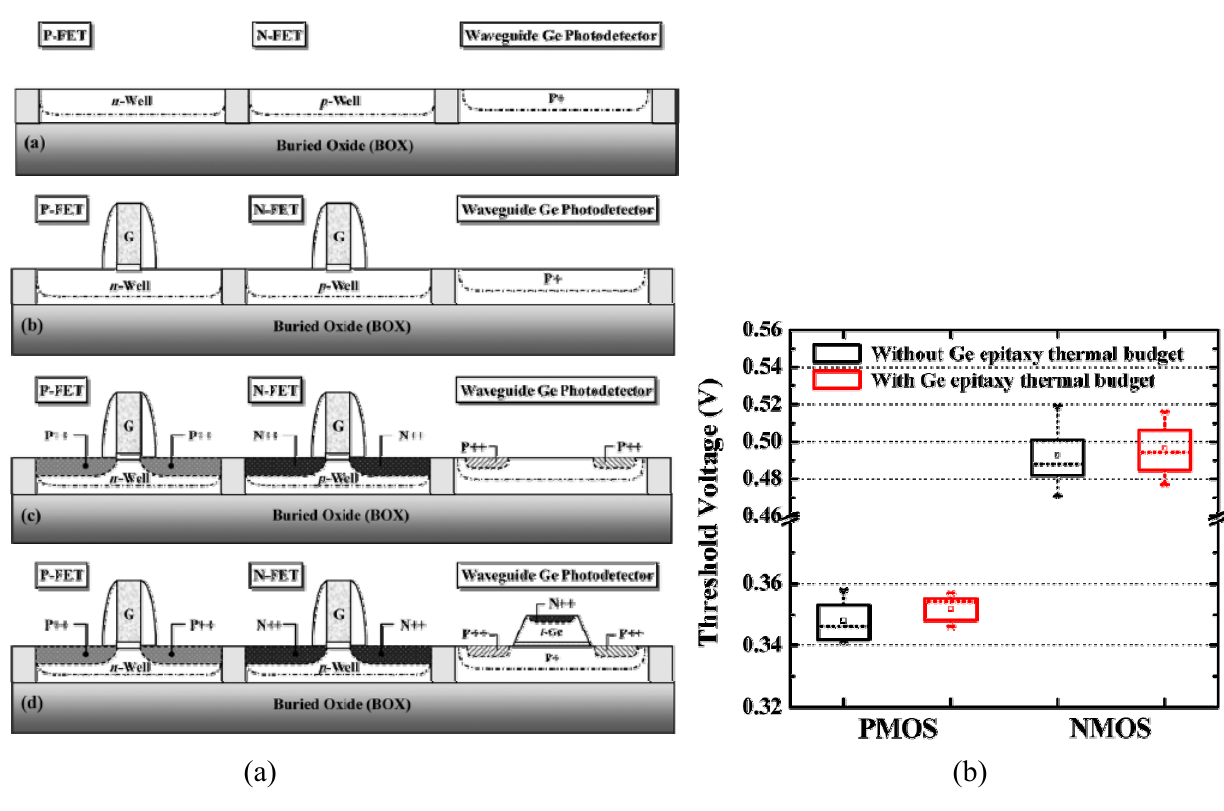
Figure 12. (a) Schematic showing the “electronic-first and photonic-last” integration approach for monolithically fabricating the Ge p-i-n photodetector and Si CMOS circuit on common SOI platform. (b) Comparable threshold voltages were observed in both n-MOS and p-MOS transistors despite the introduction of an additional thermal budget during the Ge epitaxy growth. From